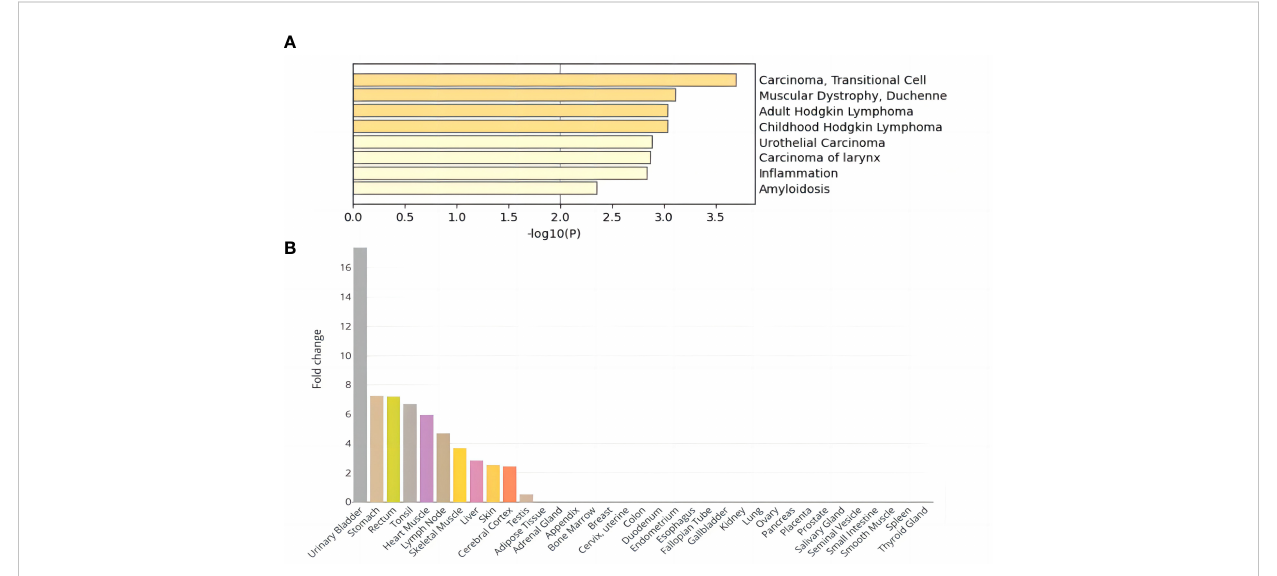
FIGURE 2 Enrichment analysis results of DEGs shared by NAFLD and T2D. (A) DisGeNET enrichment analysis results. (B) Tissue enrichment results.